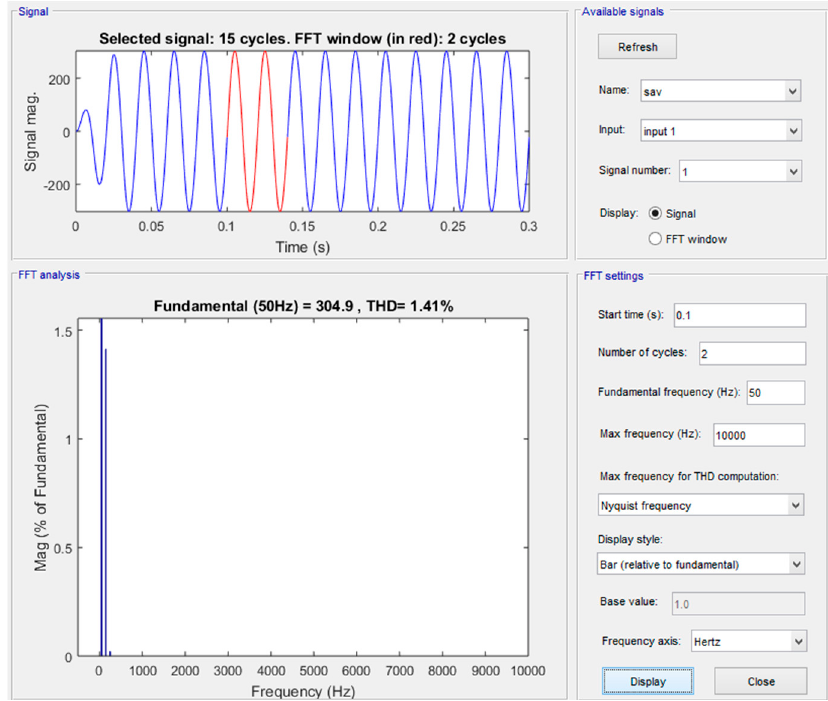
Figure 16. Fast Fourier transform (FFT) analysis of output voltage. THD, total harmonic distortion.